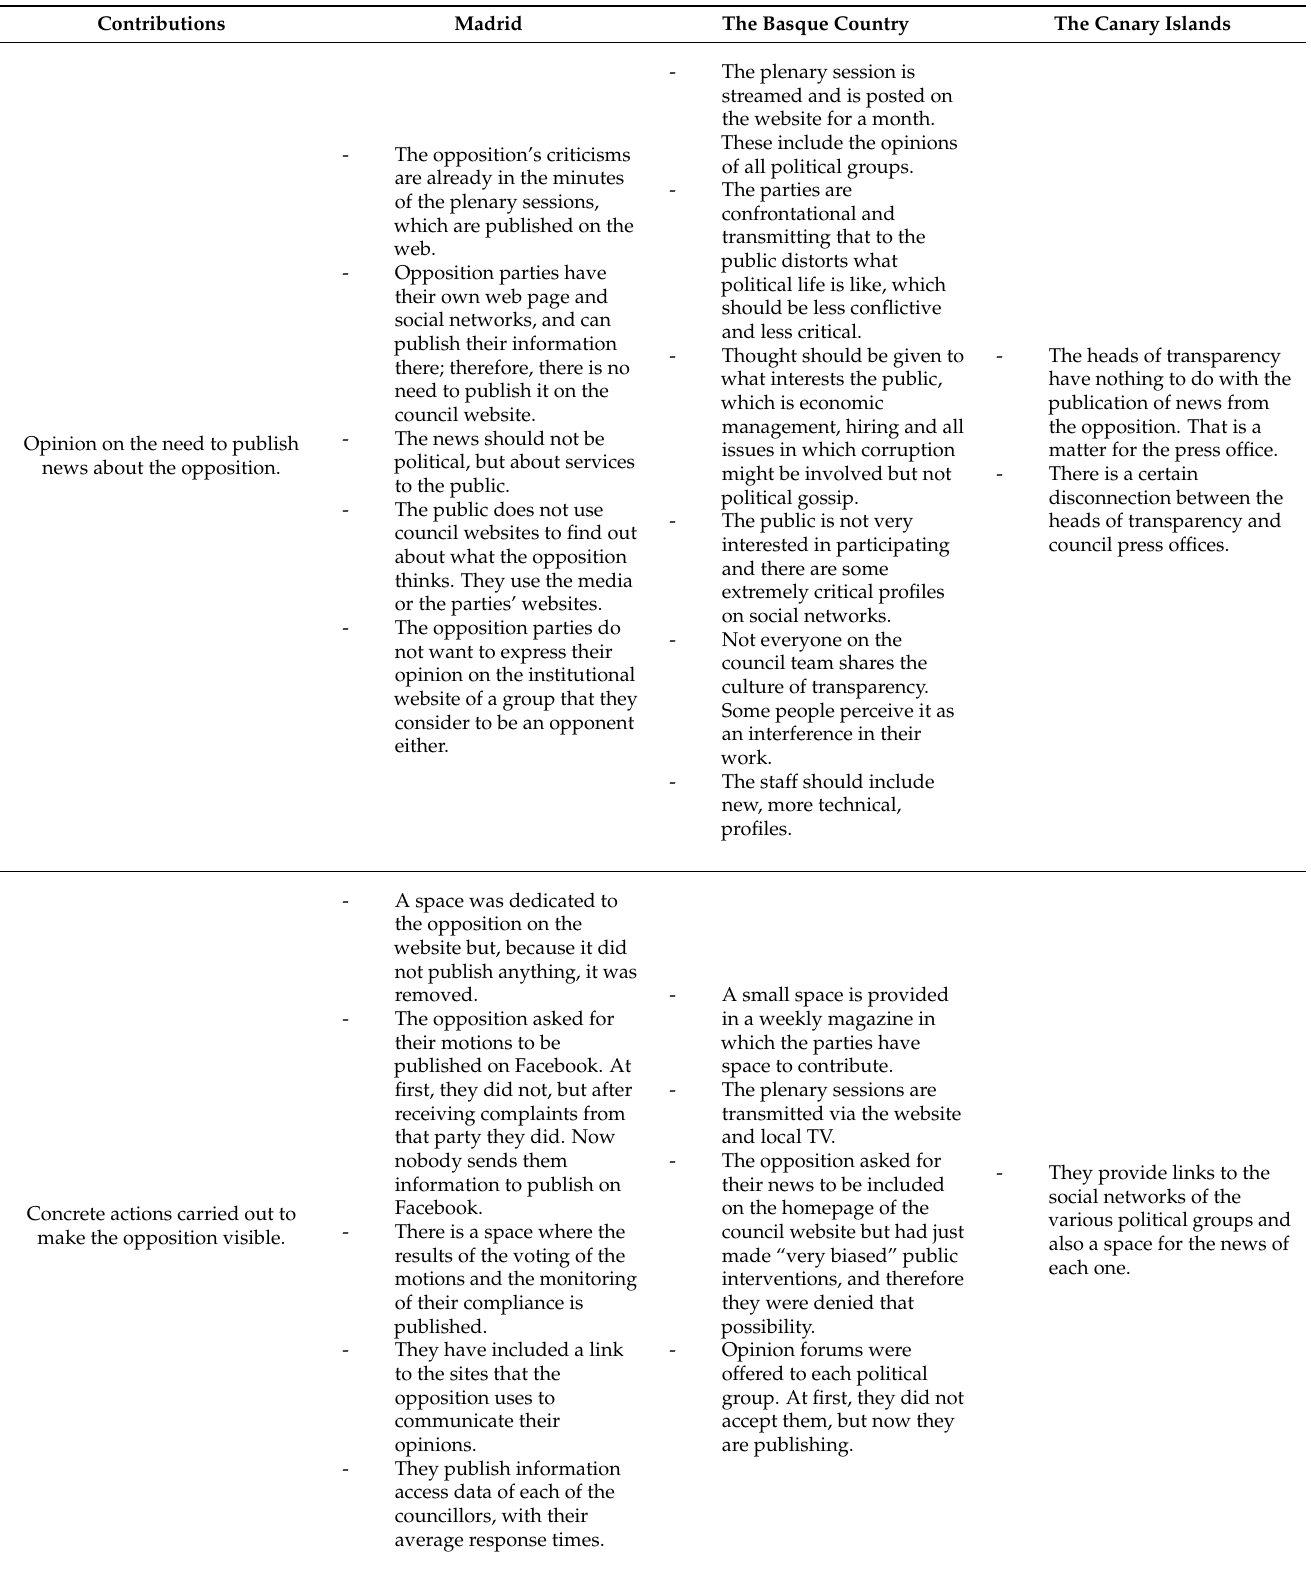
Table 2. Summary of the contributions of the technical and political council